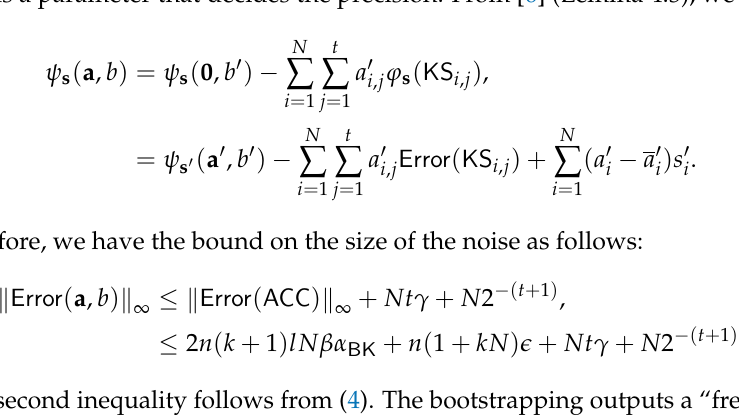
Algorithm 2 for completeness of this paper. The keyswitching key is defined as KS s